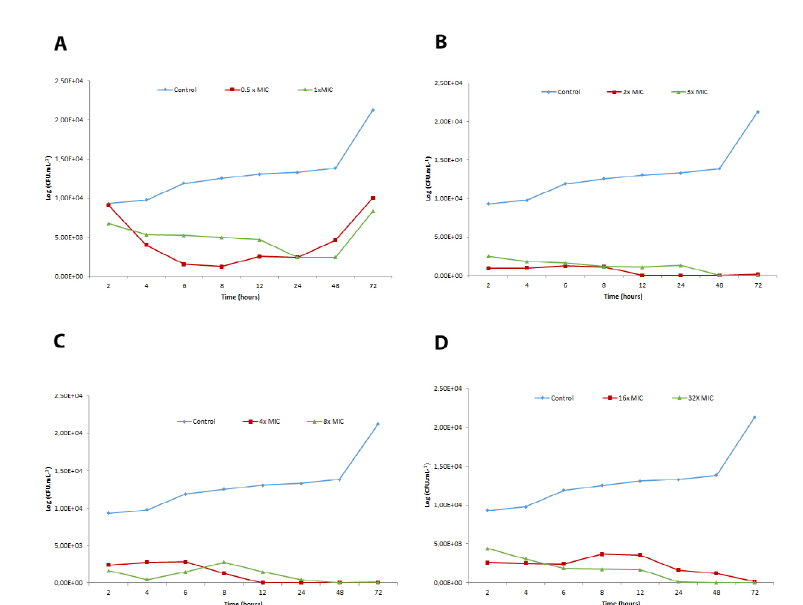
Figure 4. Time-kill curves for lireodenine against strain 32 of Cryptococcus neoformans complex. Eight doubling dilutions are plotted, the highest concentration corresponds to 32 × MIC as measured with the EUCAST microdilution method, and the blue line represents growth in absence of lireodenine. The compound was added at timepoint 0 and monitored until 72 h. The limit of detection in the assay was 33 CFU/mL. CFU: colony forming units; MIC: minimum inhibitory concentration.